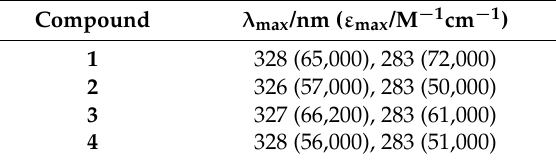
Table 3. Wavelength maxima and extinction coefficients of fac -[Fe(4-ima-Bp) 3 ](Y) 2 in MeOH. Compound